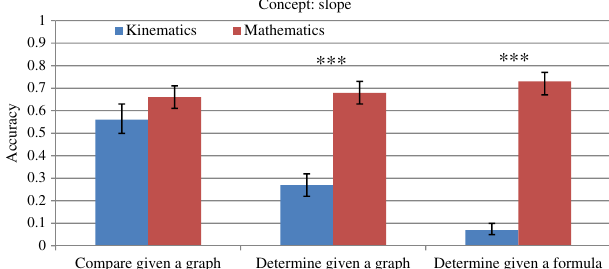
FIG. 6. GEE results for the slope in the term context * QType * concept . The p value of the comparisons is indicated by * for p < 0 . 05 , ** for p < 0 . 01 , *** for p < 0 . 001 . Highly significant differences are found between the contexts for determine given a graph and for determine given a formula question types.